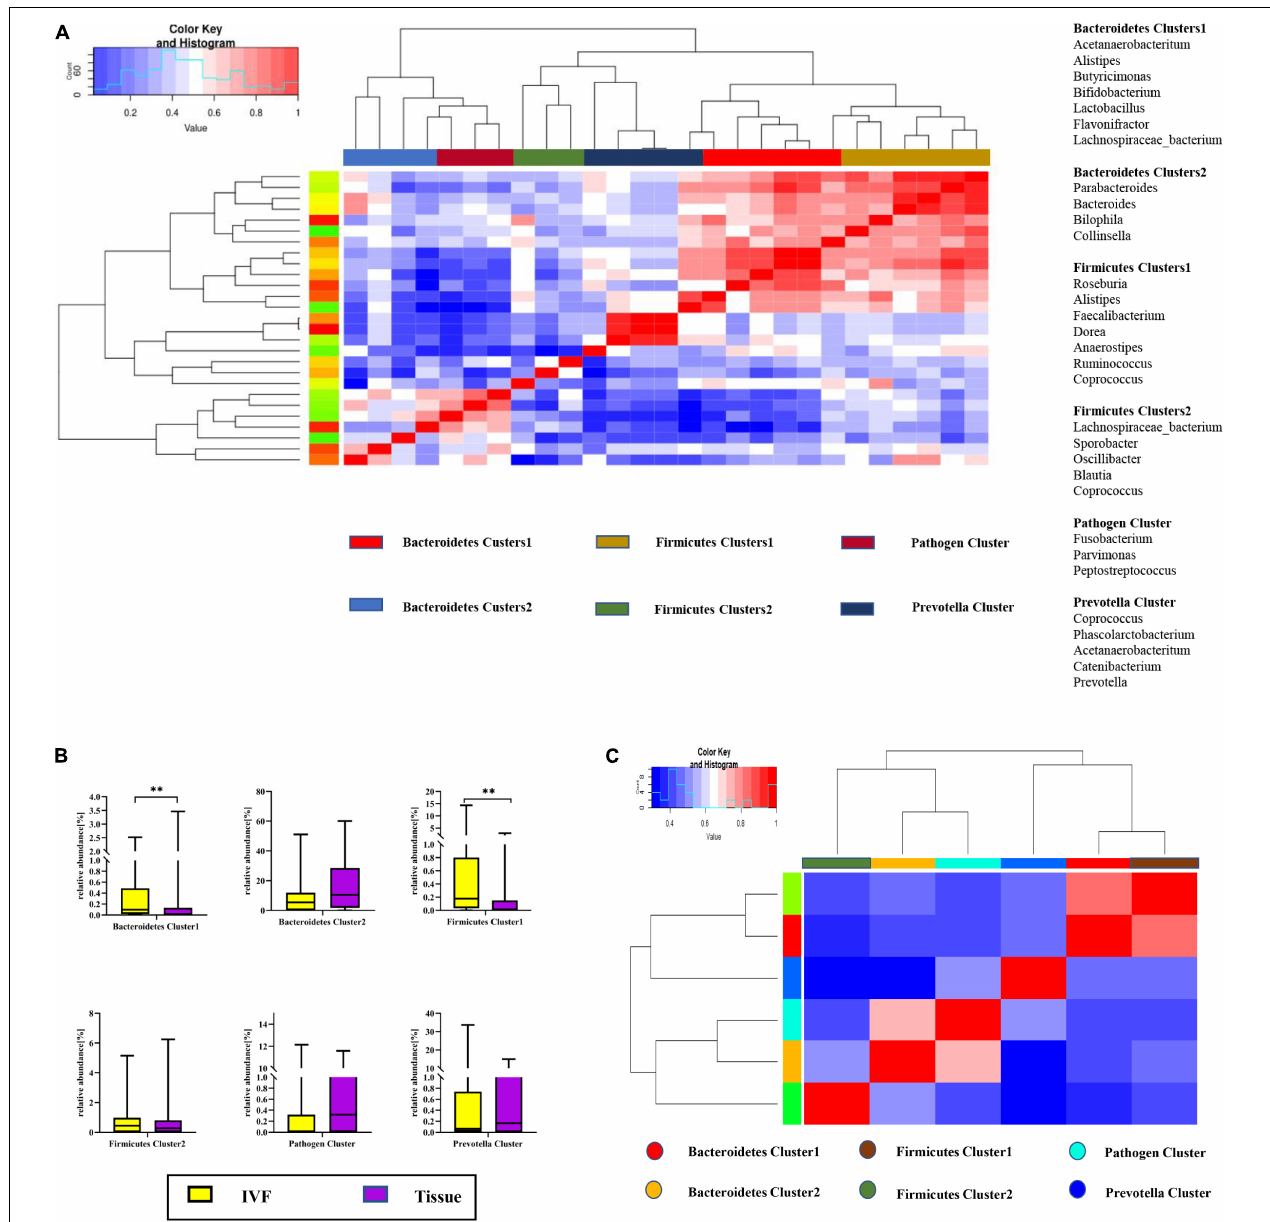
FIGURE 3 | (A) Hierarchical Ward-linkage clustering based on the Pearson correlation coefficients of the relative abundance of operational taxonomic units in IVF and tissue microbiota of 20 individuals with colorectal cancer (CRC). Bacterial clusters were defined based on the clusters in the vertical tree and named after their most notable characteristic. Column color coding is according to the legend below. The right shows the most abundant bacterial genera, and the most strongly connected genera in each bacterial cluster (i.e., genera with the highest numbers of significant positive correlations with other members of each respective group) are listed. (B) Boxplots of the relative abundances of the six co-abundance groups (CAGs) of bacterial clusters, ** p < 0.01. (C) Hierarchical Ward-linkage clustering based on the Pearson correlation coefficients of the relative abundance of CAGs in CRC samples (20